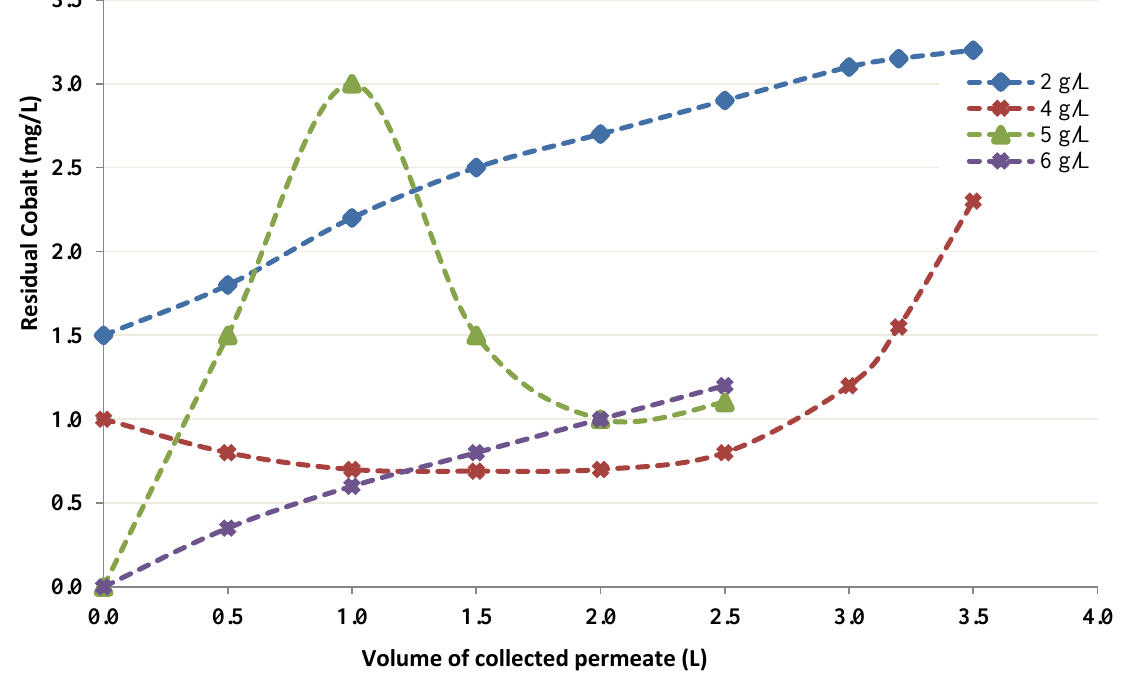
Figure 7. Permeation curve for various Chitin concentrations in CEFP.